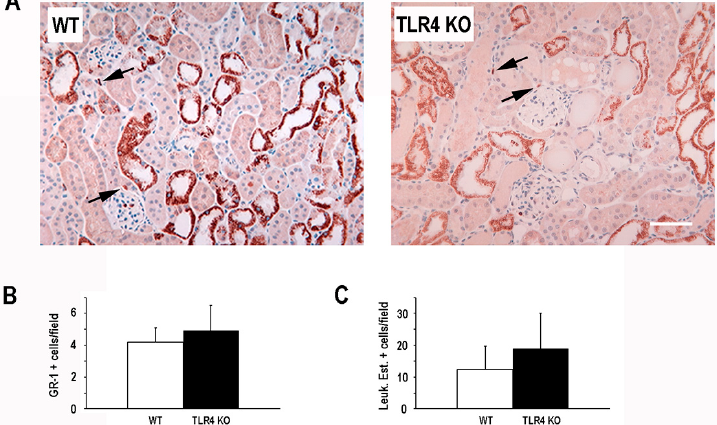
Figure 2. Cont. Figure 2.